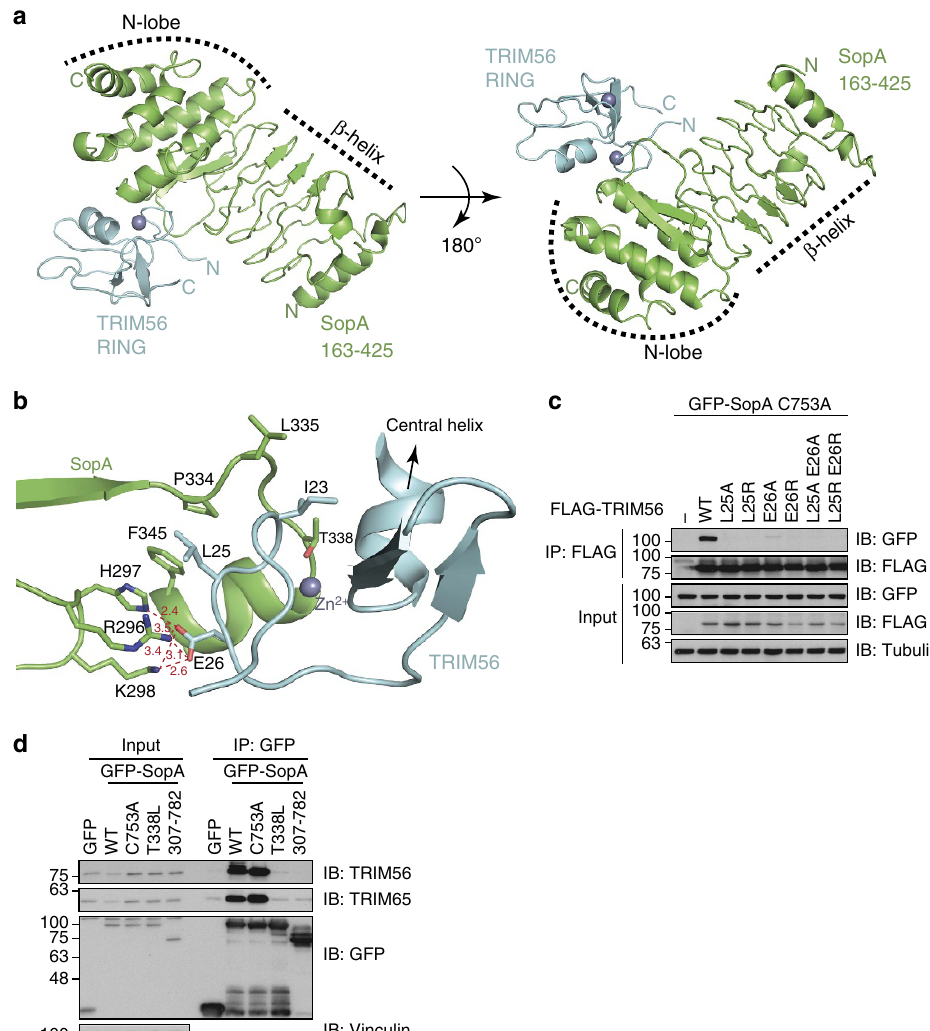
Figure 3 | Structure of SopA b -helix in complex with TRIM56 RING domain. ( a ) Crystal structure of SopA–TRIM56 complex shown in cartoon representation. SopA is shown in green and TRIM56 in cyan, two orientations rotated by x :180 (cid:2) are shown. ( b ) Enlarged view of the interface of SopA and TRIM56 showing the important residues involved in the interaction. Right conformation depicted in a was rotated by y : 140 (cid:2) , x : 145 (cid:2) and z : 35 (cid:2) and zoomed in; residues 18–48 in TRIM56 RING and 295–299, as well as 330–345 in SopA are shown. Hydrogen bonds with corresponding distances are depicted in deep red. ( c ) TRIM56 RING mutations abolish SopA interaction. Lysates from cells co-expressing GFP-SopA C753A and indicated FLAG-TRIM56 RING domain mutants were subjected to anti-FLAG IP, followed by SDS–PAGE and immunoblotting. ( d ) SopA T338L mutation abolishes SopA–TRIM56 and SopA–TRIM65 interaction. Lysates from cells expressing indicated GFP-SopA b -helix point mutants were subjected to anti-GFP IP, followed by SDS–PAGE and